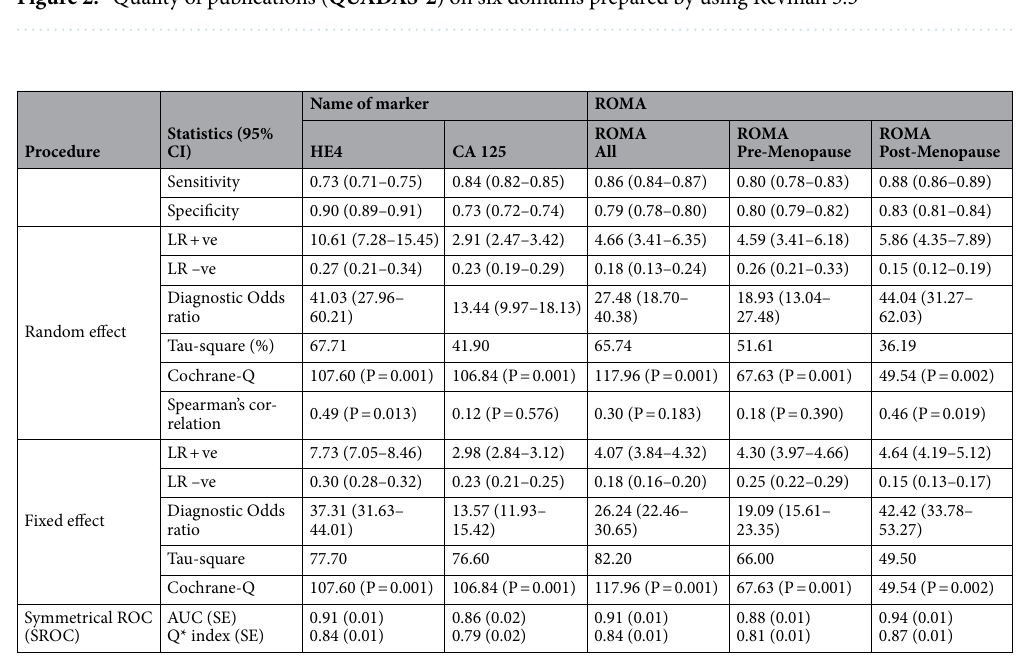
Figure 2. Quality of publications ( QUADAS-2 ) on six domains prepared by using Revman 5.3